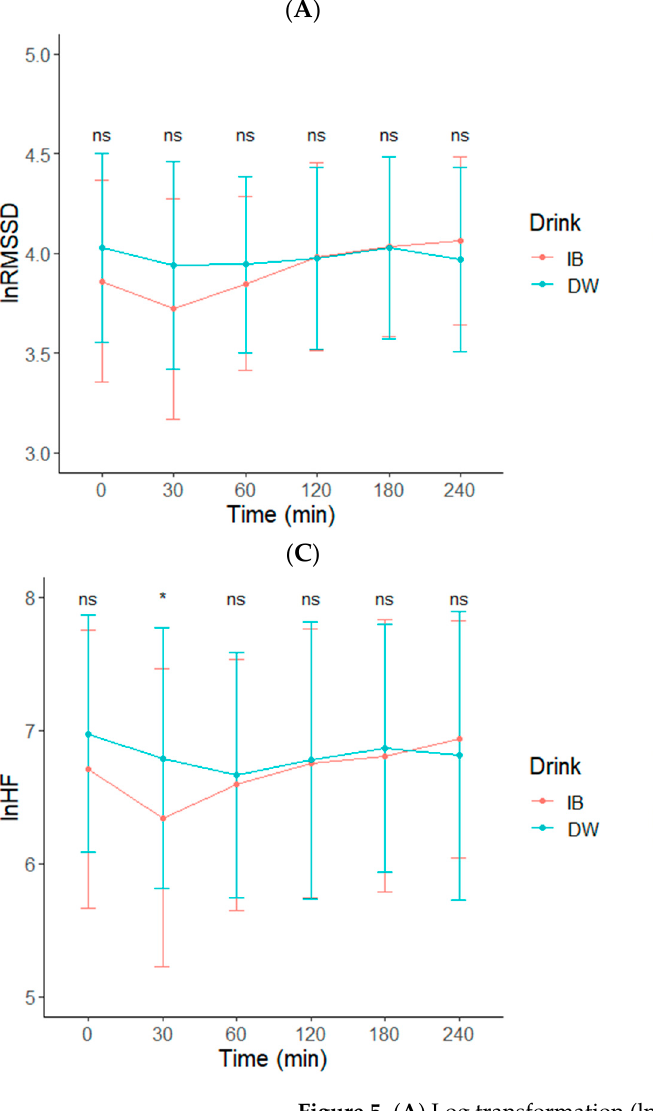
Figure 5. ( A ) Log transformation (ln) of the root mean square (lnRMSSD), ( B ) low frequency (lnLF), ( C ) high frequency (lnHF), and ( D ) pre-ejection period (PEP) following isotonic beverage (IB) or distilled water (DW). * Denotes a significant Drink * Time interaction, p < 0.05. Non-significant interactions are denoted by NS in all figures.